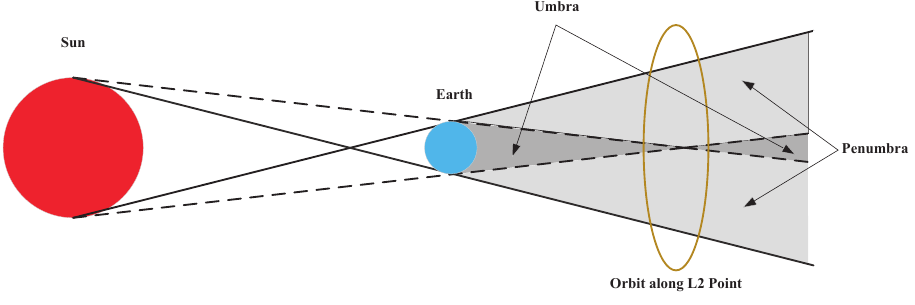
Figure 4. Schematic diagram of Earth-shadow